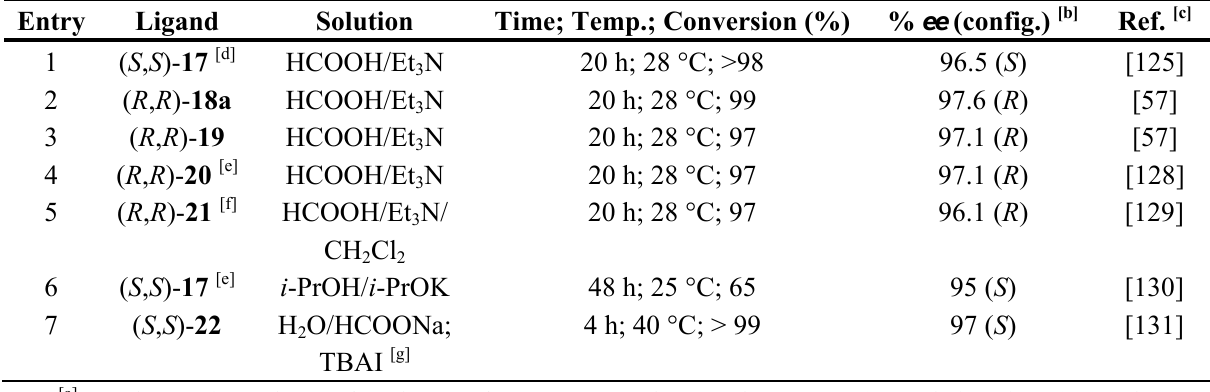
Table 6. ATH of acetophenone using dendritic catalysts [a]